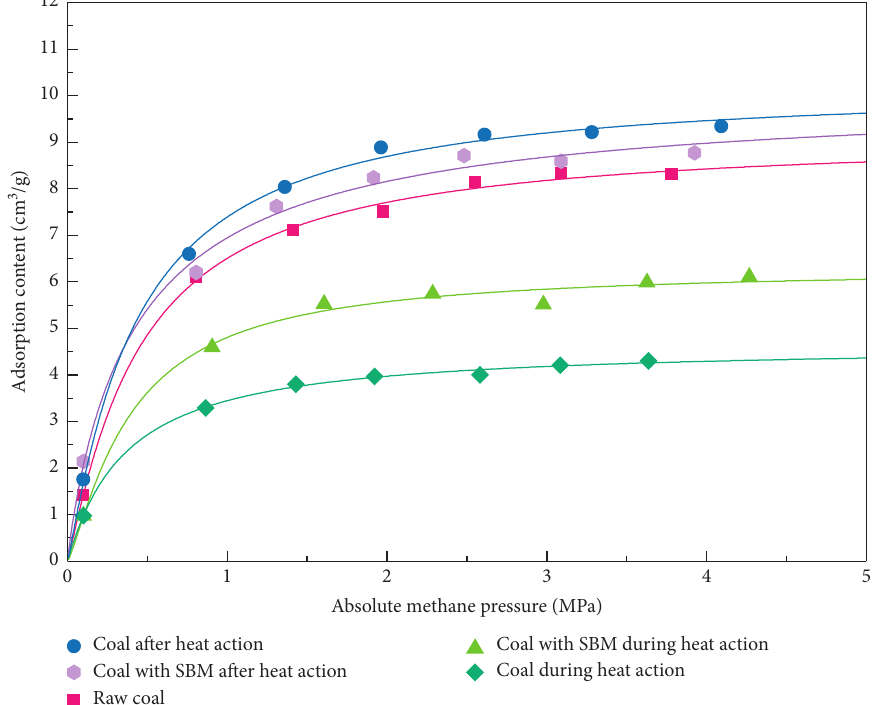
Figure 11: Methane adsorption curve of coal under static blasting material